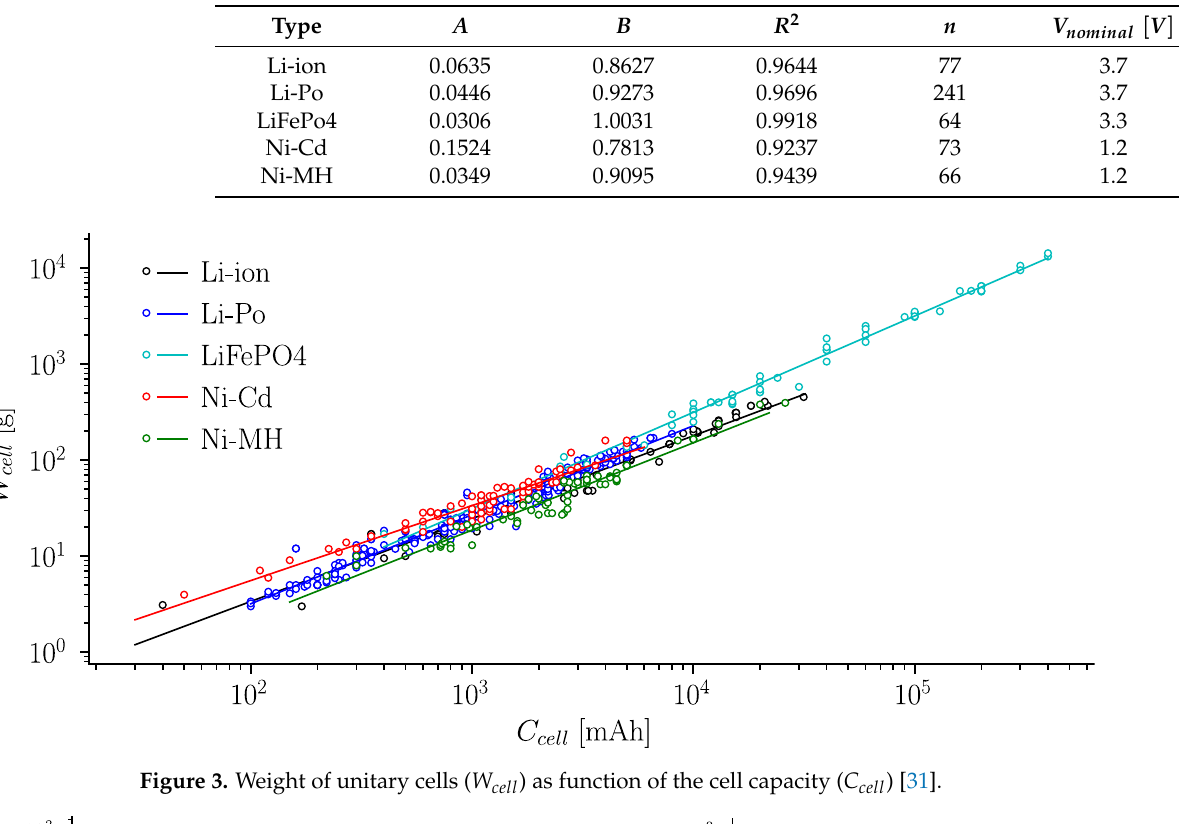
Table 1. Regression coefficients for unitary cells. W cell = A · C cell B [31].